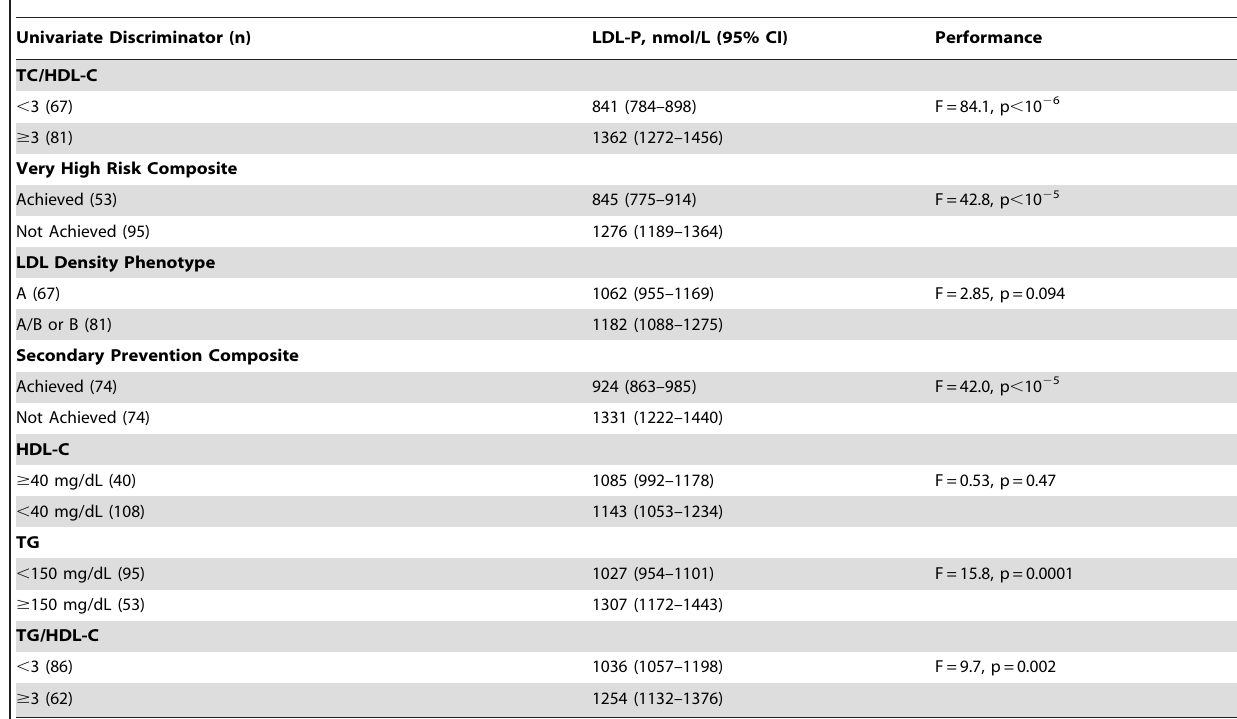
Table 1. Univariate Discrimination of LDL-P and Performance by Lipid Criteria.